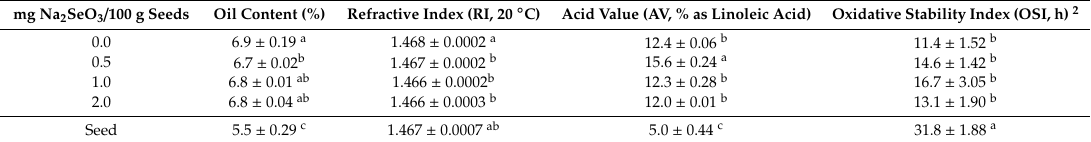
Table 1. Physical and chemical properties of chickpea oils obtained from sprouts germinated for four days with di ff erent levels of sodium selenite 1